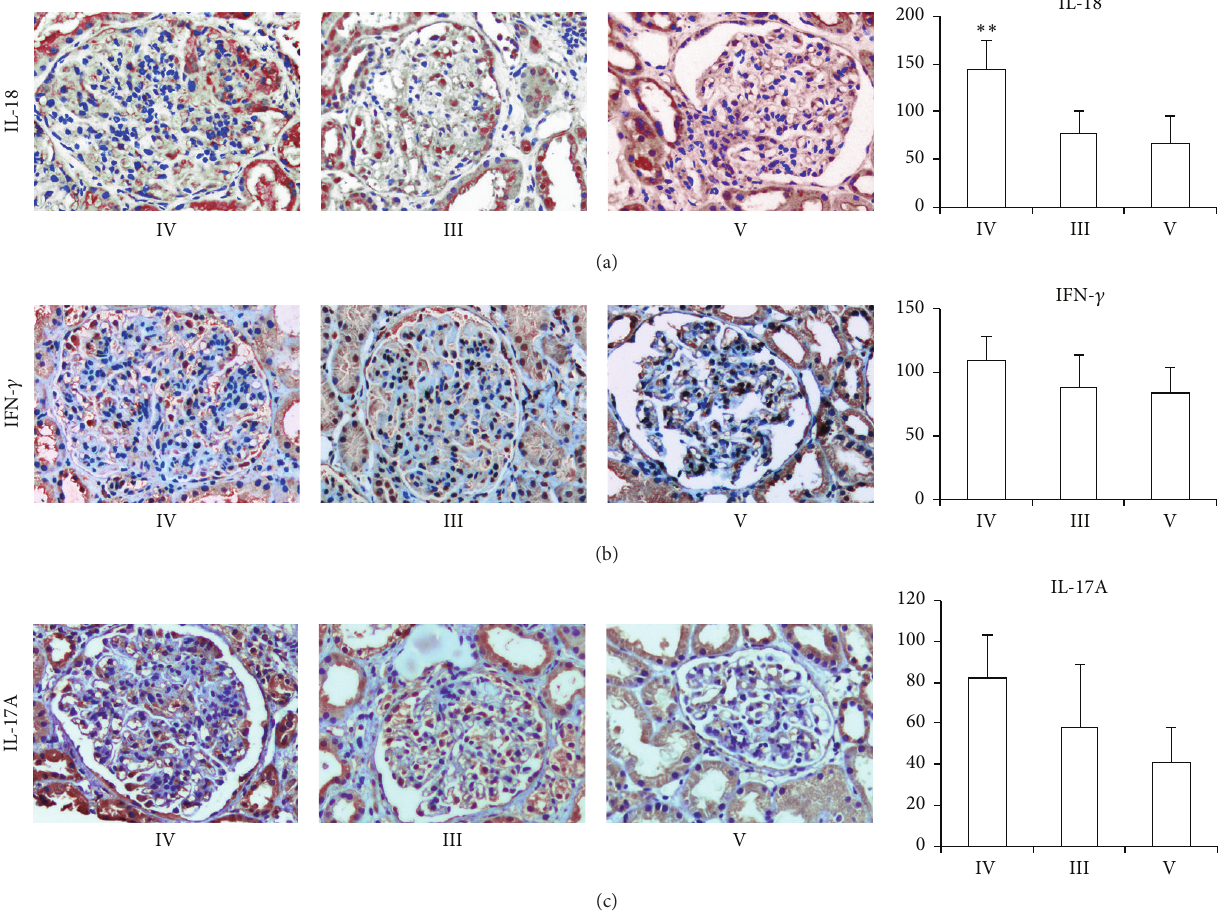
Figure 2: Localized expressions of IL-18, IL-17A, and IFN- 𝛾 in renal tissues of patients with LN-III, LN-IV, and LN-V. Expression of IL-18, IFN- 𝛾 , and IL-17A as shown in the level of brown color (dark to light) was detected in LN-IV patients ( 𝑛 = 5 ), LN-III patients ( 𝑛 = 3 ), and LN-V patients ( 𝑛 = 2 ), respectively. The cytokines expressions in infiltrating mononuclear cells (MNCs) of glomerulus were examined from 0 to 3 and glomeruli were analyzed (original magnification 200x). ∗∗ 𝑝 value < 0.01. 𝑝 value < 0.05 was considered statistically